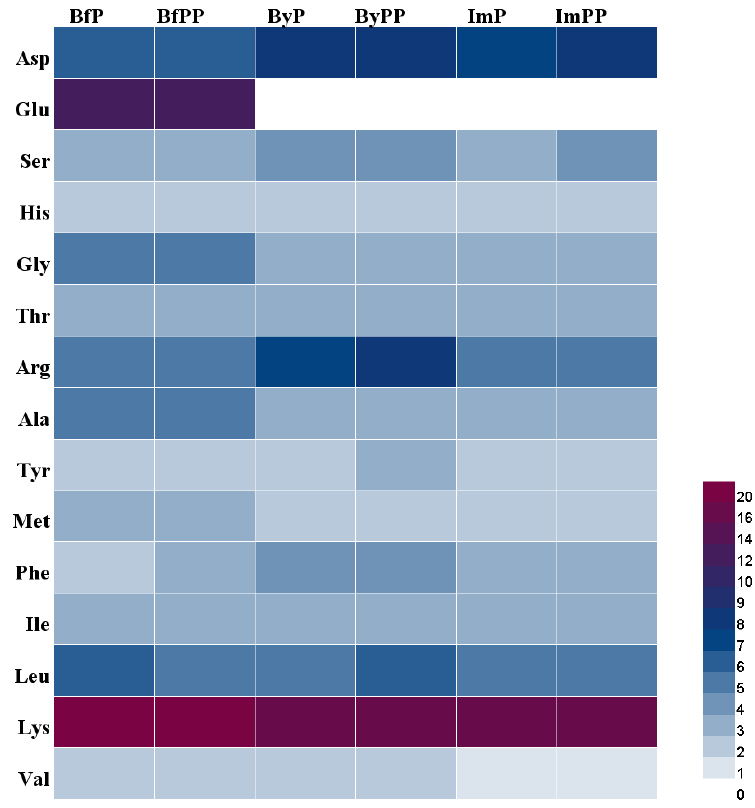
Figure 2. The amino acid compositions of beef and PBMA